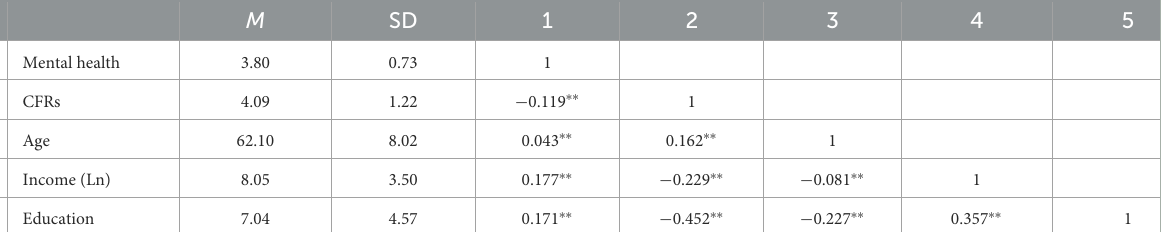
TABLE 1 Descriptive statistics and correlations for main variables ( N = 4,237).